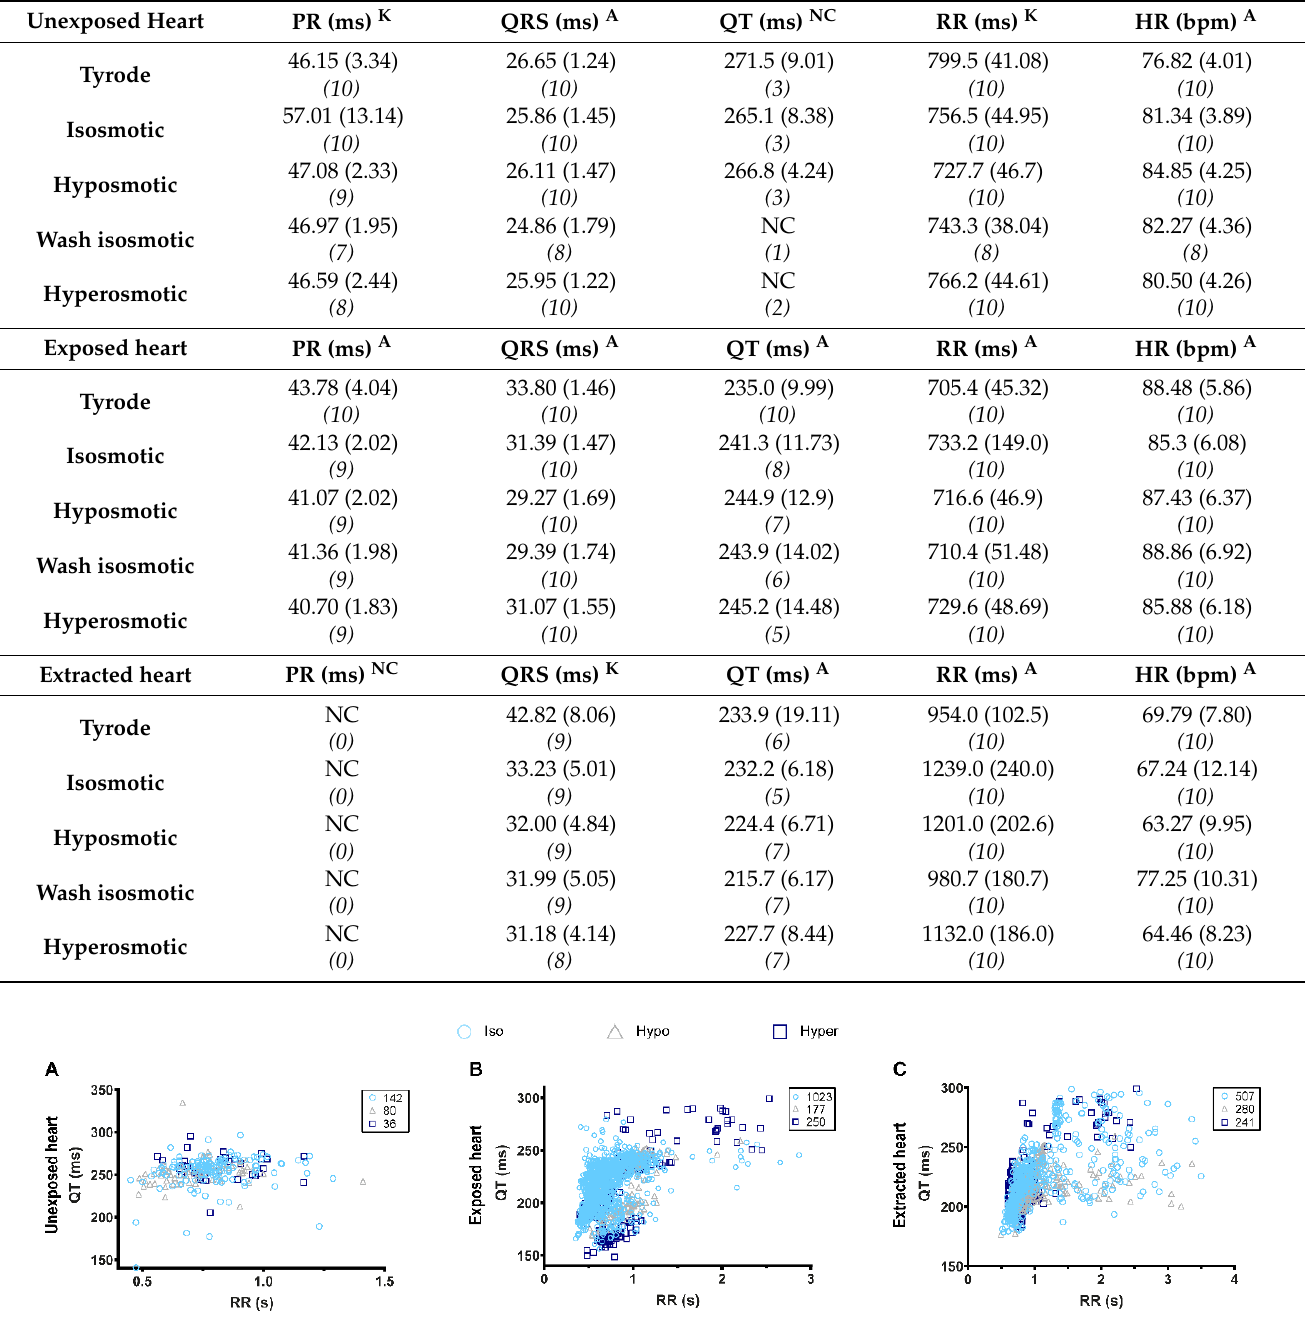
Figure 2. QT-RR relationship in different configurations of ECG measurement. ( A ), Unexposed heart; ( B ), exposed heart; ( C ), extracted heart. The number of individual QT-RR pairs, obtained in isosmotic, hyposmotic, and hyperosmotic conditions, is presented in the upper right corner of each graph and was obtain from n = 3 (unexposed heart), n = 10 (exposed heart), and n = 6 (extracted heart) adult zebrafish.